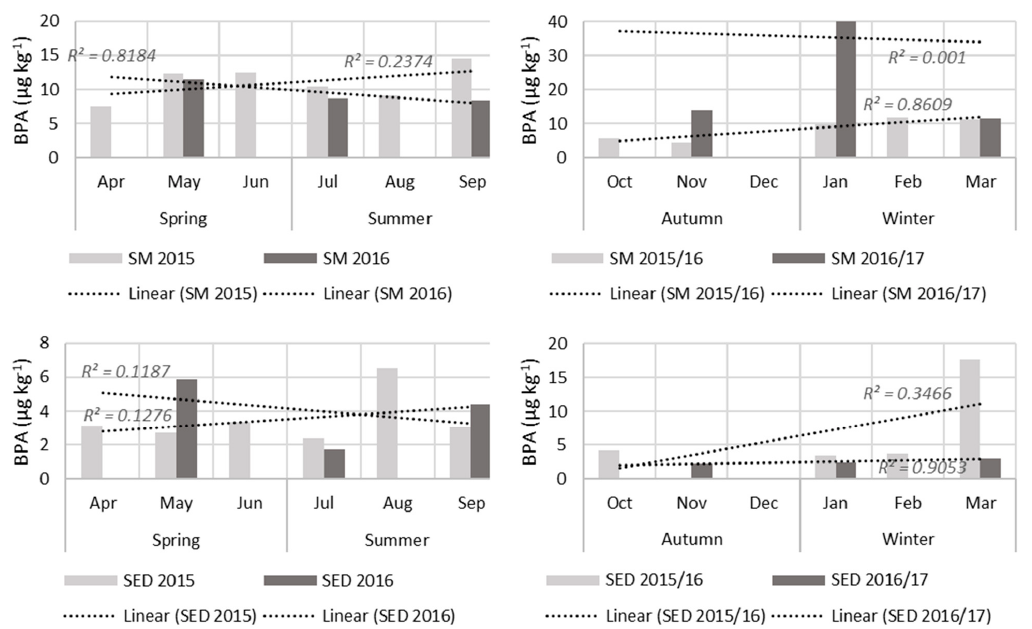
Figure 9. Average monthly BPA concentrations for suspended matter (SM) and sediment samples (SED) collected at stations S1 to S3 in the Kaštela Bay (Adriatic Sea, Croatia ) over two years (April 2015 to March 2017), represented by the cold (October to March) and warm (April to September) seasons.